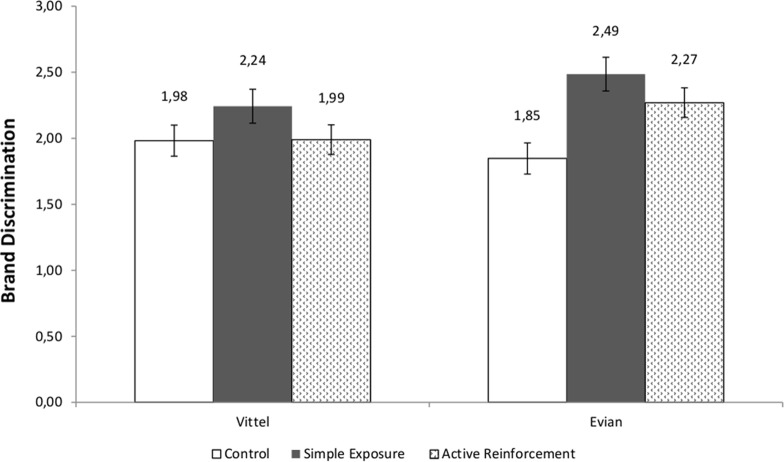
Brand Discrimination scores for Vittel and Evian as function of the Experimental Condition, Study 2.Note: Standard error bars are shown for each mean.